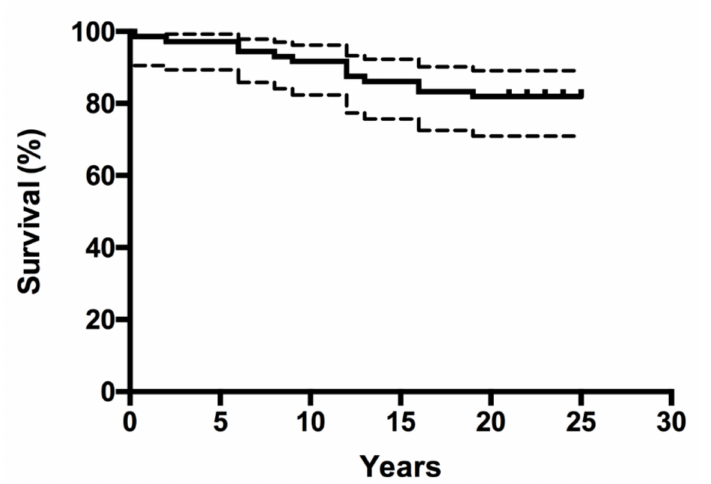
Figure 3. Kaplan–Meier survivorship curve (and corresponding 95% confidence intervals) for all seventy-two hips, with revision for any reason as the end